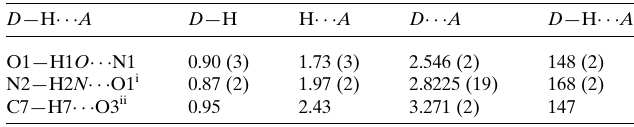
Table 1 Hydrogen-bond geometry (A˚ , (cid:3) ) for I .